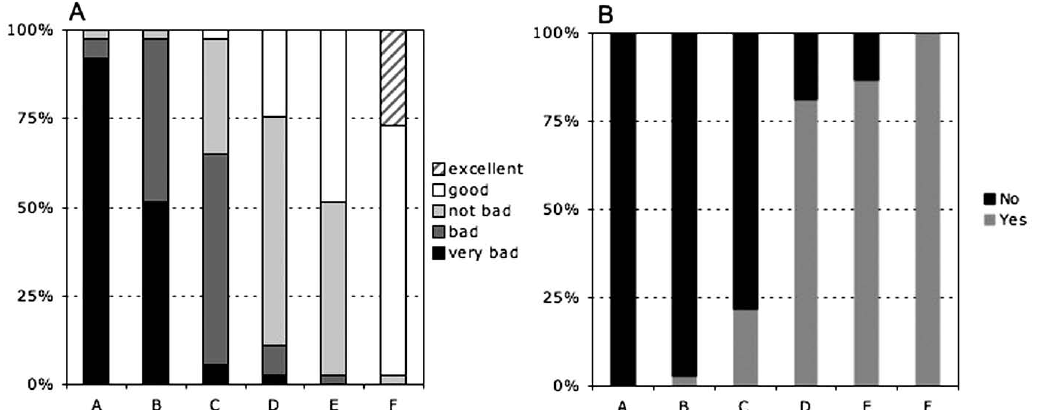
Fig . 4. – Fishery of P. pollicipes in the RNB: (A) relative opinion (very bad to excellent) of harvesters regarding the size of a set of 6 reference barnacles with different RC lengths (A-14 mm, B-17 mm, C-20.1 mm, D-22 mm, E-25.3 mm and F-29.6 mm) and (B) relative number of positive and negative answers to the question of whether the harvesters would collect barnacles with those sizes (n=37